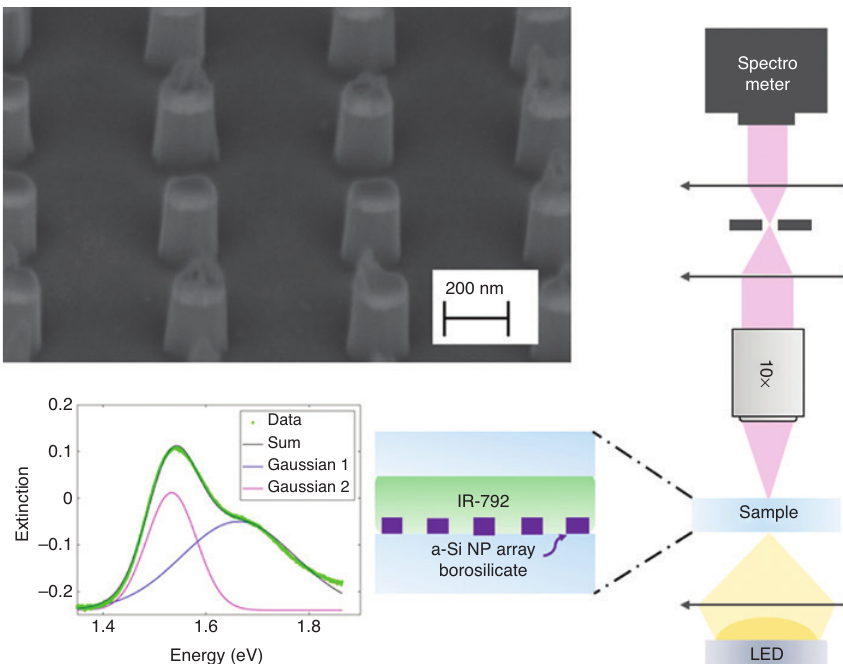
Figure 1: The sample and measurement setup. (A) SEM picture of an amorphous silicon sample before chromium etching. (B) Transmission measurement setup and schematic of the sample with the dye. (C) Absorption spectrum of IR-792 with a concentration of 100 mm solved in PMMA A3. We fit two Gaussians to the spectrum, shown by the pink and blue curves. The pink curve corresponds to the main absorption